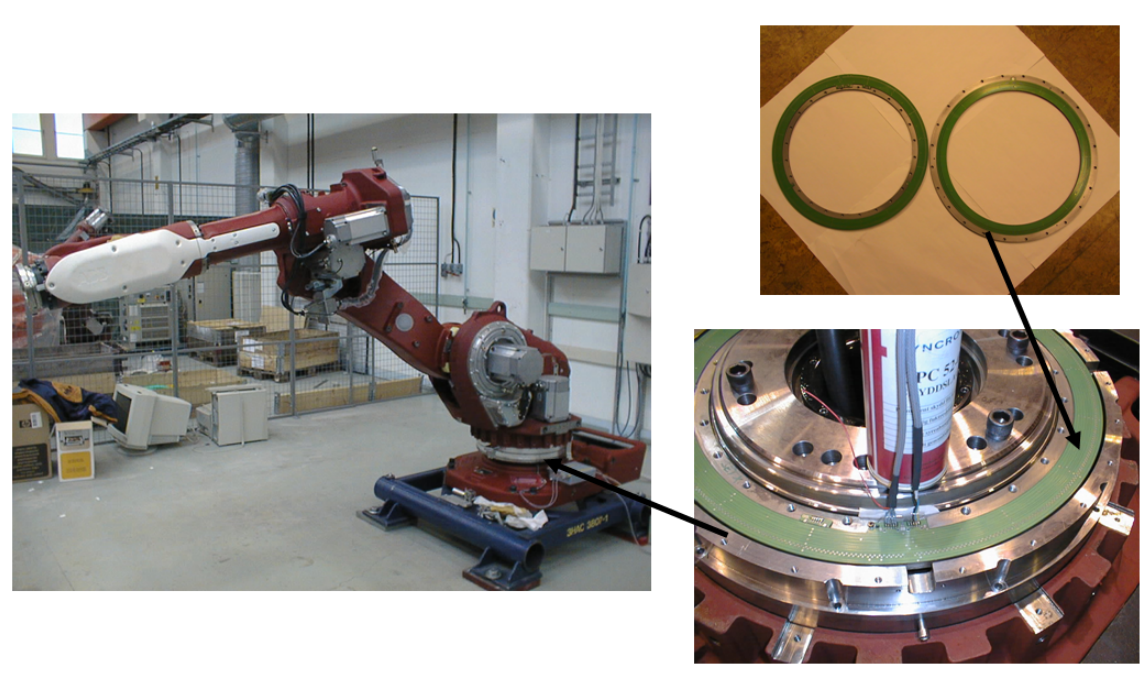
Figure 14: Photos from tests of using a capacitive encoder integrated in a robot joint to accurately measure the joint angle on the low speed side of the gear box. In this way the repeatability could be improved a factor of 7 and the control robustness a factor of